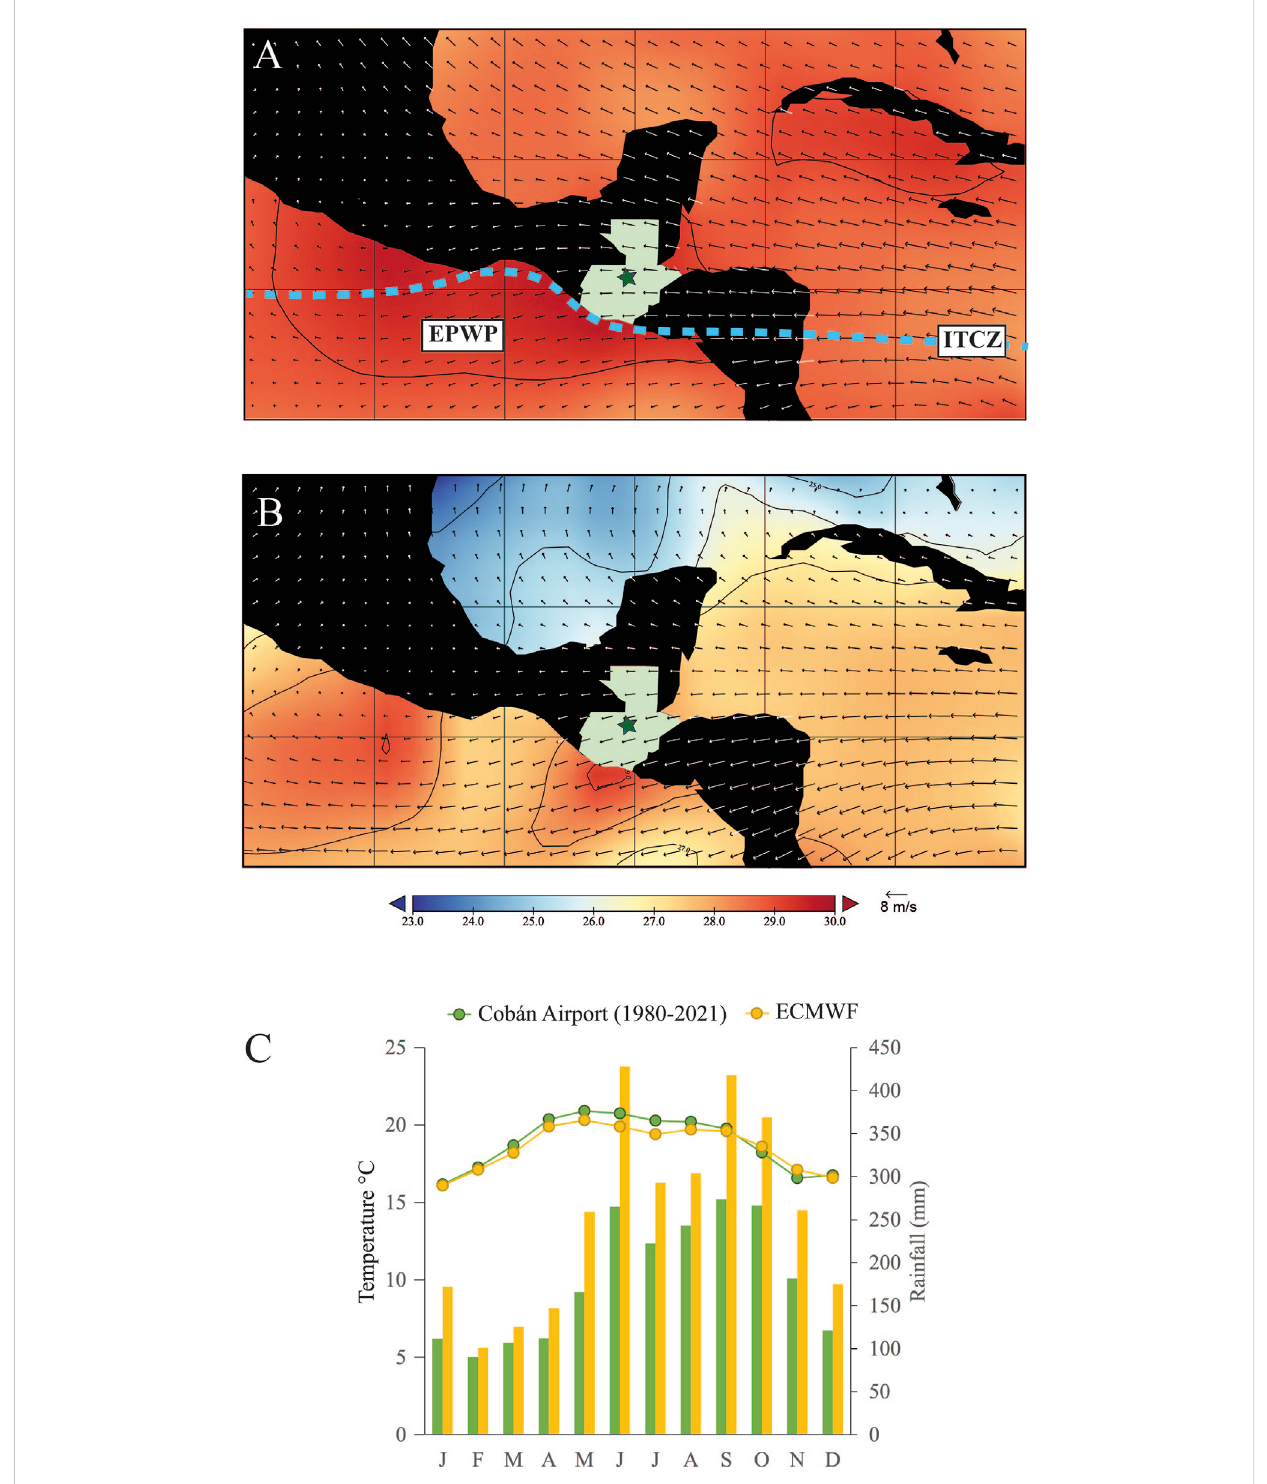
FIGURE 1 Location of Gruta del Rey Marcos in central Guatemala (A) May-October 1980 – 2010 average sea surface temperature and 850 mBar wind vectors, highlighting the Eastern Paci fi c Warm Pool (EPWP). Image provided by the NOAA/ESRL Physical Sciences Laboratory, Boulder Colorado from their Web site at http://psl.noaa.gov/- blue dashed line indicates the approximate position of the ITCZ during the northern hemisphere summer. (B) November – April 2,980 – 2010 average SST and wind vectors. (C) Monthly average (1980 – 2020) temperature and rainfall for Coban using data for Coban Airport (INSIVUMEH, 2021) and from the European Center for Medium-Range Weather Forecast, obtained from